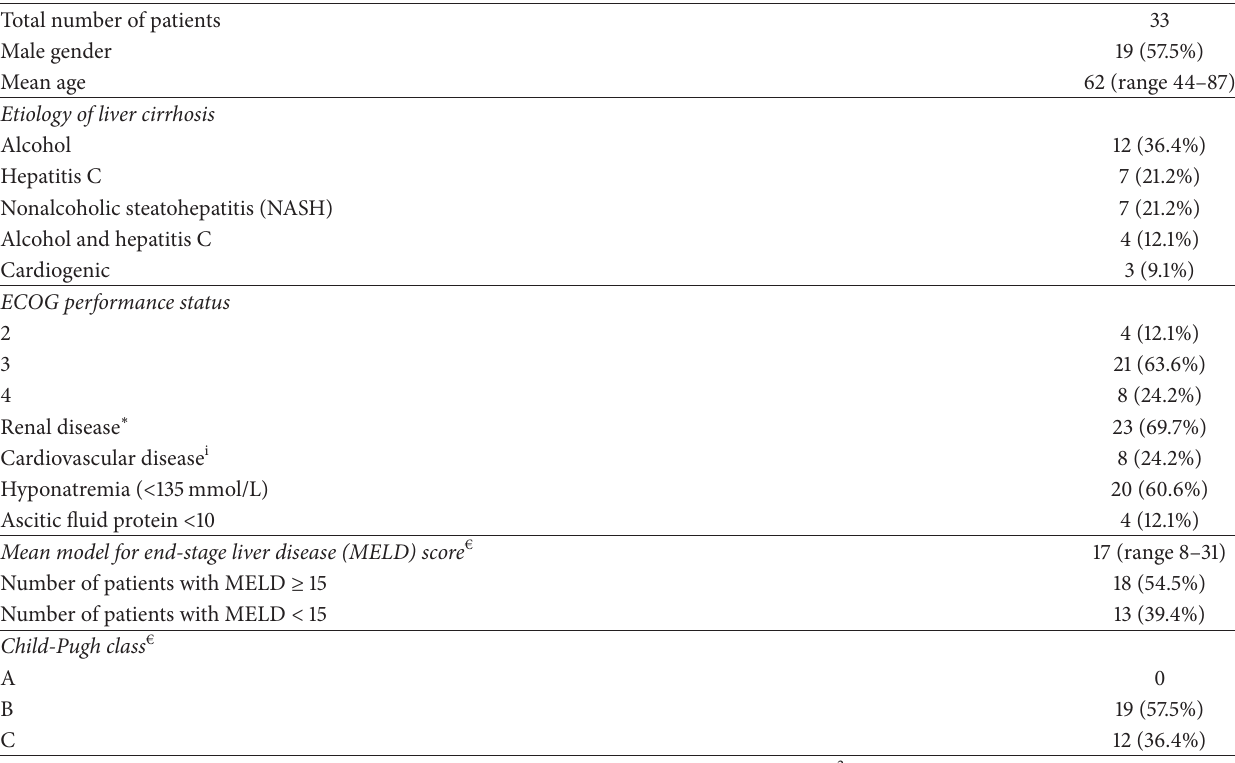
Table 1: Patient demographics and baseline clinical characteristics.